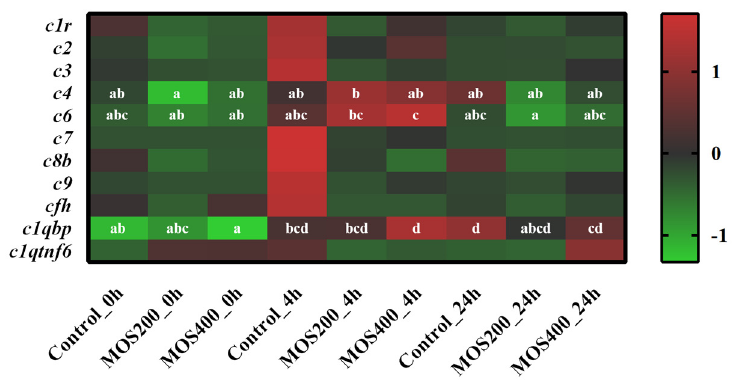
Figure 4. Heatmap of complement-related genes based on digital gene expression (DGE) profiling. The color values represented up-regulated (red) and down-regulated (green) expressions of selected DEGs, which ranged from 1 to − 1. Different alphabets indicate statistically significant differences after performing Tukey’s HSD test ( p < 0.05).